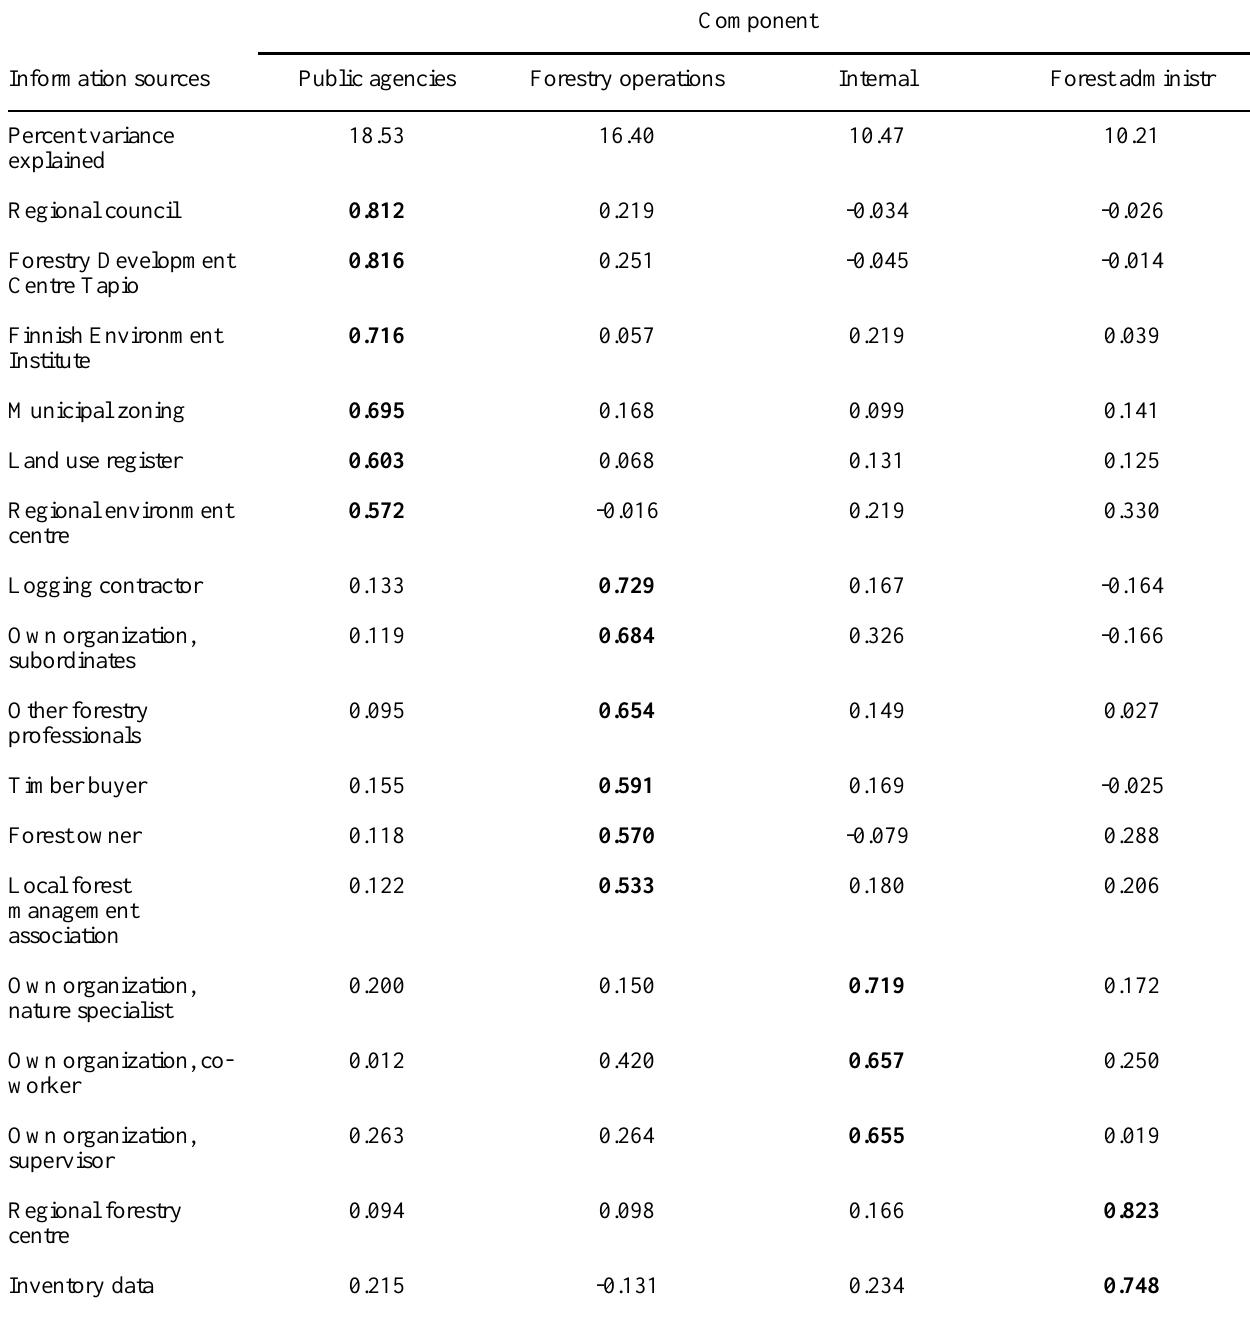
Table A2-2. Princial component scores for information sourcing (scores > 0.5 bolded).